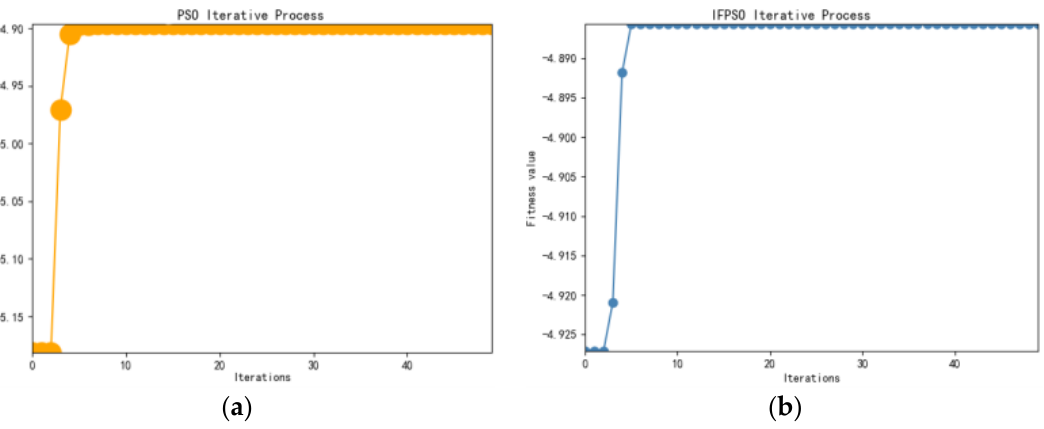
Figure 5. Comparison of Hang Seng index results of algorithm optimization search. ( a ) PSO, ( b ) IFPSO.